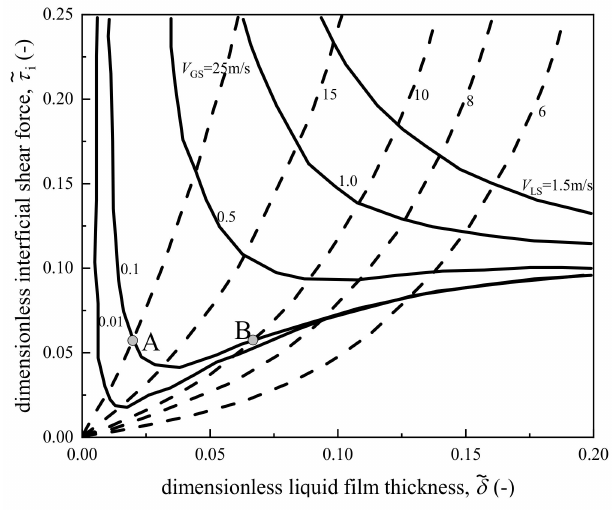
Figure 1. Relationship between dimensionless interfacial shear force and liquid film